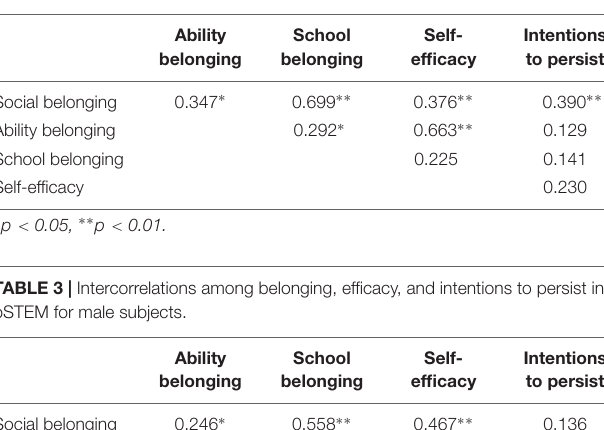
TABLE 2 | Intercorrelations among belonging, efficacy, and intentions to persist in pSTEM for female subjects.